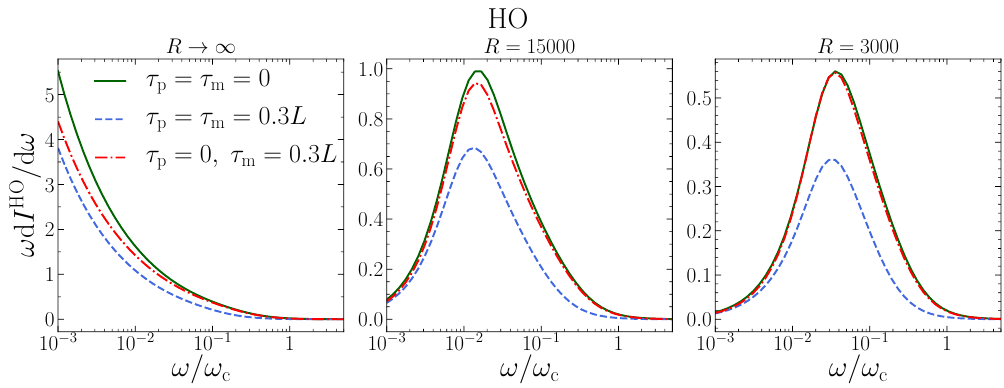
Figure 7 . HO medium-induced energy spectrum as function of ω/ω c for the three scenarios an- alyzed in this paper: τ p = τ m = 0 (green solid lines); τ p = τ m = 0 . 3 L (blue dashed lines); and τ p = 0 and τ m = 0 . 3 L (red dash-dotted lines). The different panels correspond to different sets of R : R → ∞ (left), R = 15000 (central) and R = 3000